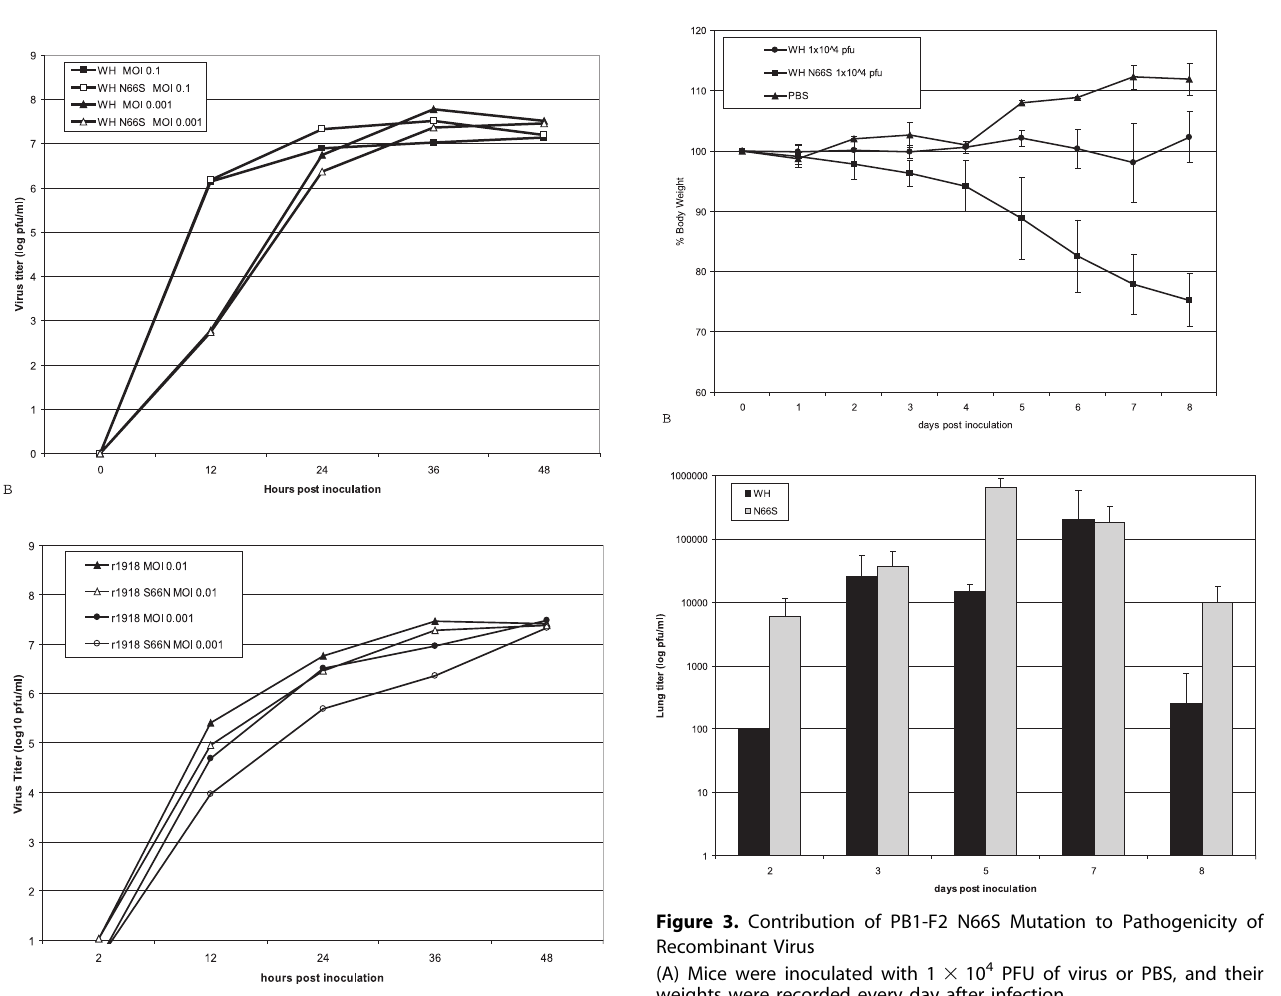
Figure 2. In Vitro Growth Curve of Recombinant Viruses (A) MDCK cells were inoculated at an MOI of 0.1 and 0.001, and virus growth of WH and WH N66S was assessed at the time points indicated. The figure is representative of three similar experiments. (B) MDCK cells were inoculated at an MOI of .01 and .001, and virus growth of r1918 and r1918 S66N was assessed at the time points indicated.